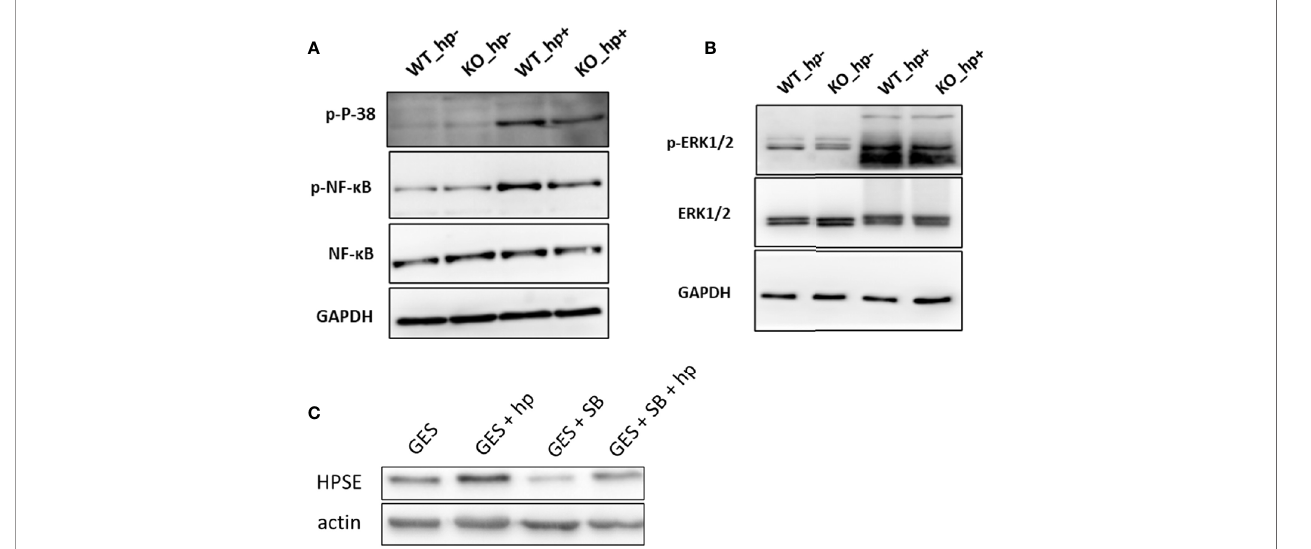
FIGURE 6 | Stimulation of macrophage activation by H. pylori is associated with p38 MAPK and NF- k B phosphorylation. (A) Peritoneal macrophages were isolated from WT and Hpa-KO mice and inoculated without or with 200 MOI H. pylori for 6 h. Cell extracts were then prepared and subjected to immunoblotting applying anti-phospho-p38 (upper panel), anti-phospho-NF ĸ B (second panel), anti-total NF- ĸ B (third panel) and anti-GAPDH (lower panel) antibodies. Cell extracts were similarly blotted with anti-phospho-Erk (B , upper panel ) , anti-Erk (B , second panel ) and anti-GAPDH (B , lower panel ) antibodies (C) Heparanase expression. GES-1 cells were left untreated (GES) or were treated with H. pylori (200MOI; GES + H. pylori ) without or with the p38 inhibitor SB203580 (20 m M; GES + SB + H. pylori ) added 2 h before the bacteria. Cell extracts were prepared after 6 h and subjected to immunoblotting applying anti-heparanase (upper panel) and anti-actin (lower panel)